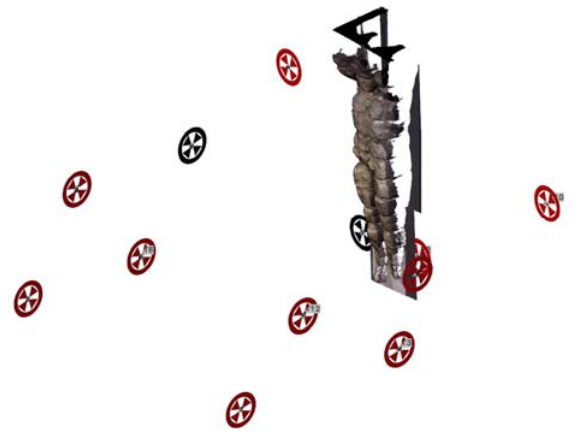
Figure 7. Positions of the reflective